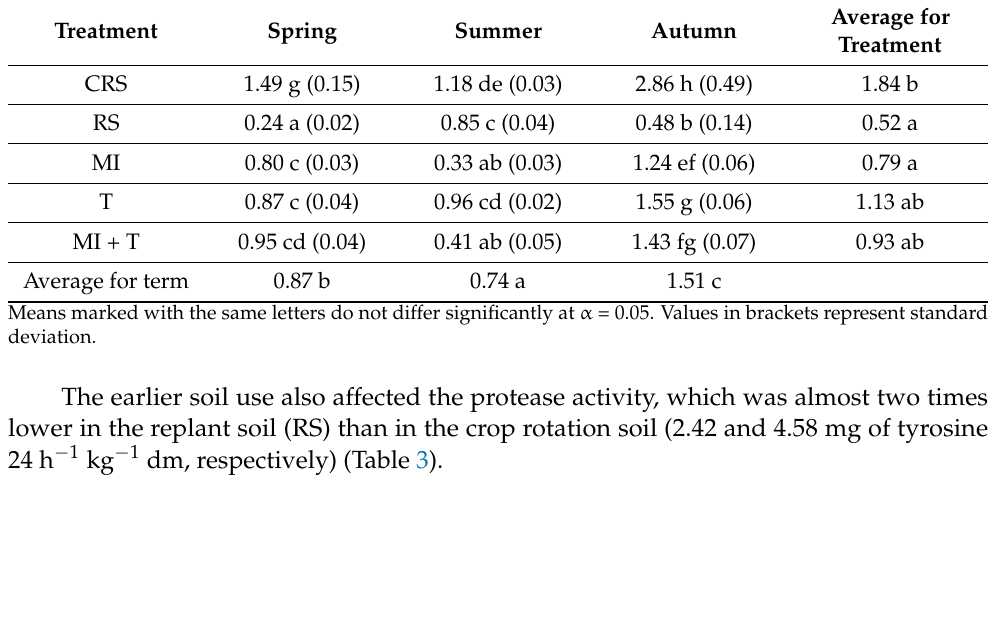
Table 2. Dehydrogenases activity in the soil (cm 3 H 2 24 h − 1 kg − 1 dm) in the year 2015–2016 (CRS = crop rotation soil; RS = replanted soil; MI = mycorrhizal inoculum; T = Trichoderma ; MI + T = mycorrhizal inoculum + Trichoderma ).